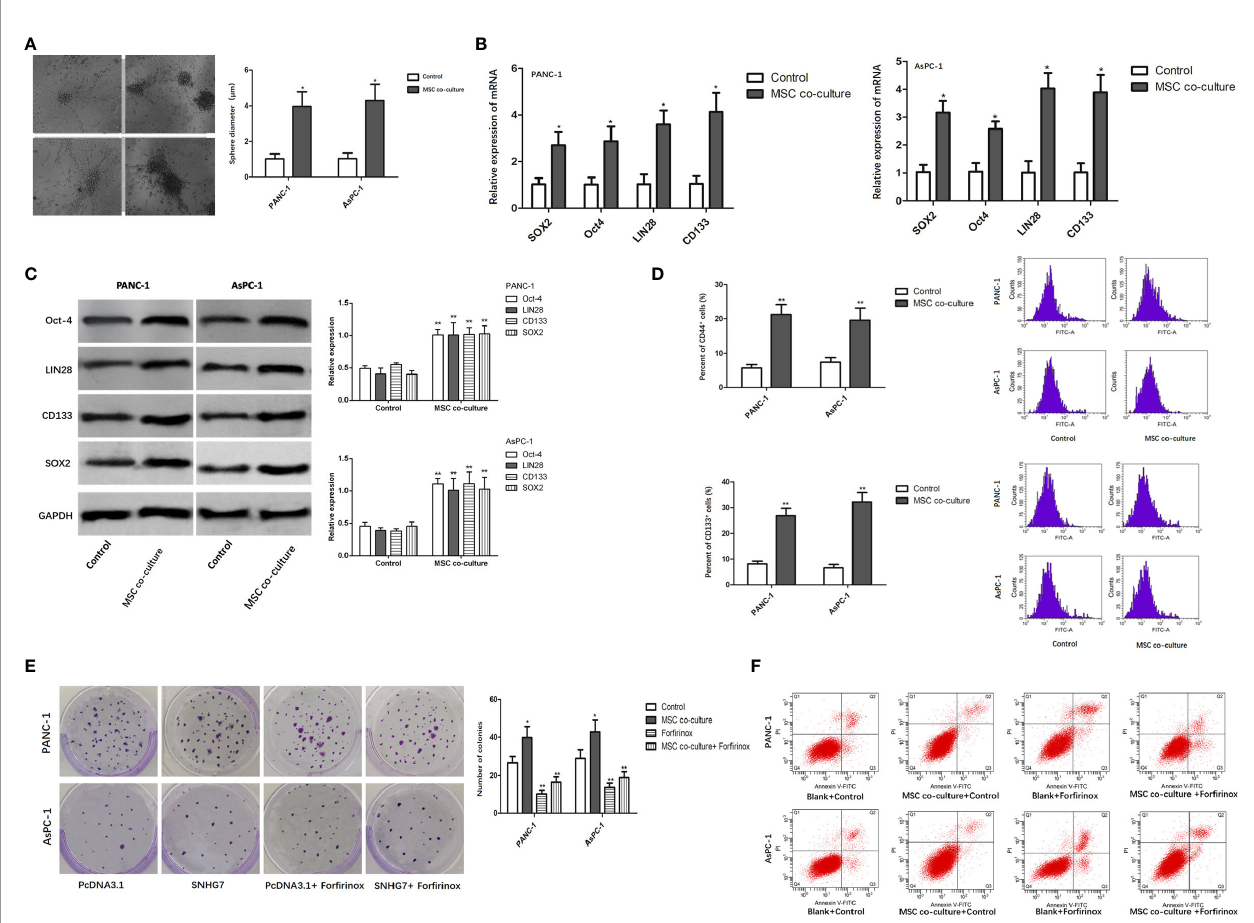
FIGURE 1 | MSCs promote the stemness and Fol fi rinox resistance of pancreatic cancer cells. (A) Representative images and quanti fi cation of the tumor spheres generated by PANC-1, AsPC-1 cells with or without the co-culture with MSCs. (B, C) The expression of stemness markers were analyzed by using qRT-PCR and Western blot assays. (D) Flow cytometry analysis showed the rate of CD44+ cells upon MSC co-culture. (E, F) Colony-formation and fl ow cytometry analyses to detected the PANC-1, AsPC-1 cells with or without MSCs. *P < 0.05, **P <